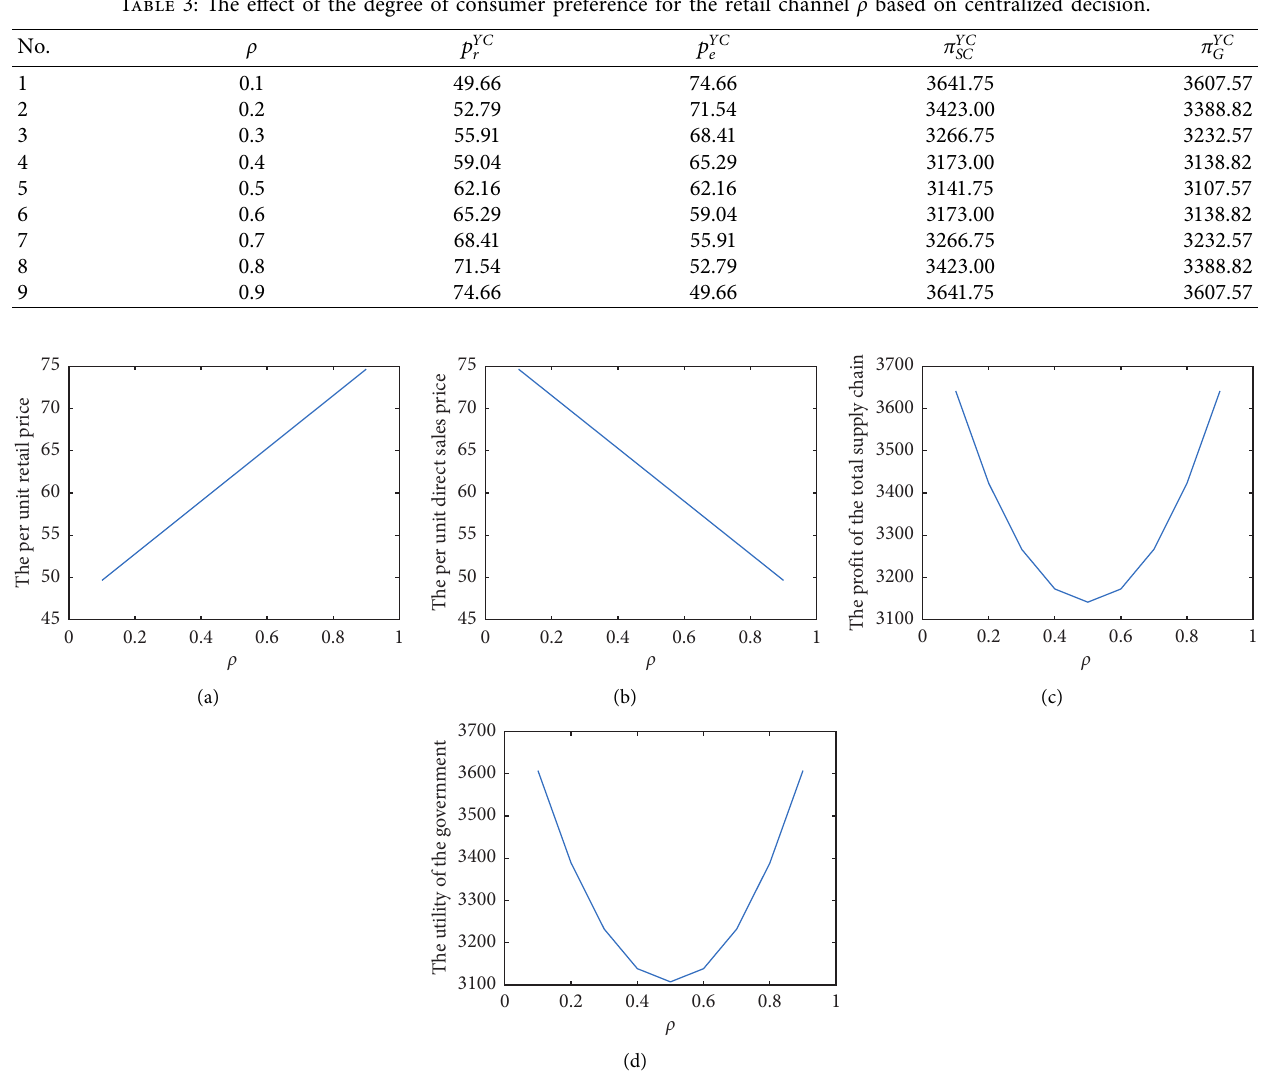
Figure 2: The effect of the degree of consumer preference for the retail channel ρ based on centralized decision.